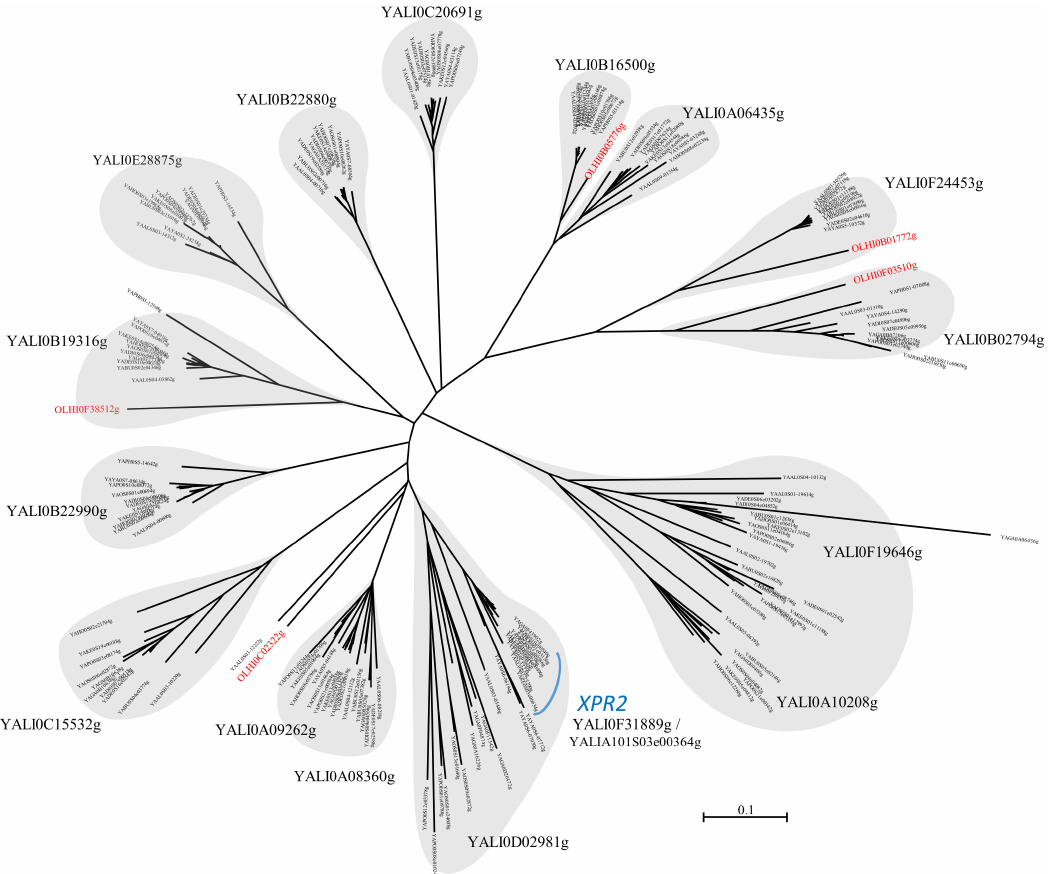
Figure 1. Unrooted circular phylogenetic tree showing the relationship between the alkaline proteases found in the genomes of Yarrowia clade species. The thirteen groups of proteins are depicted by grey clouds. The tree was constructed with phyML with a LG evolutionary model. Proteins closely related to XPR2 are highlighted by a blue curve. Protein-coding genes of Y. lipolytica are in large characters, and those of C. hispaniensis are in